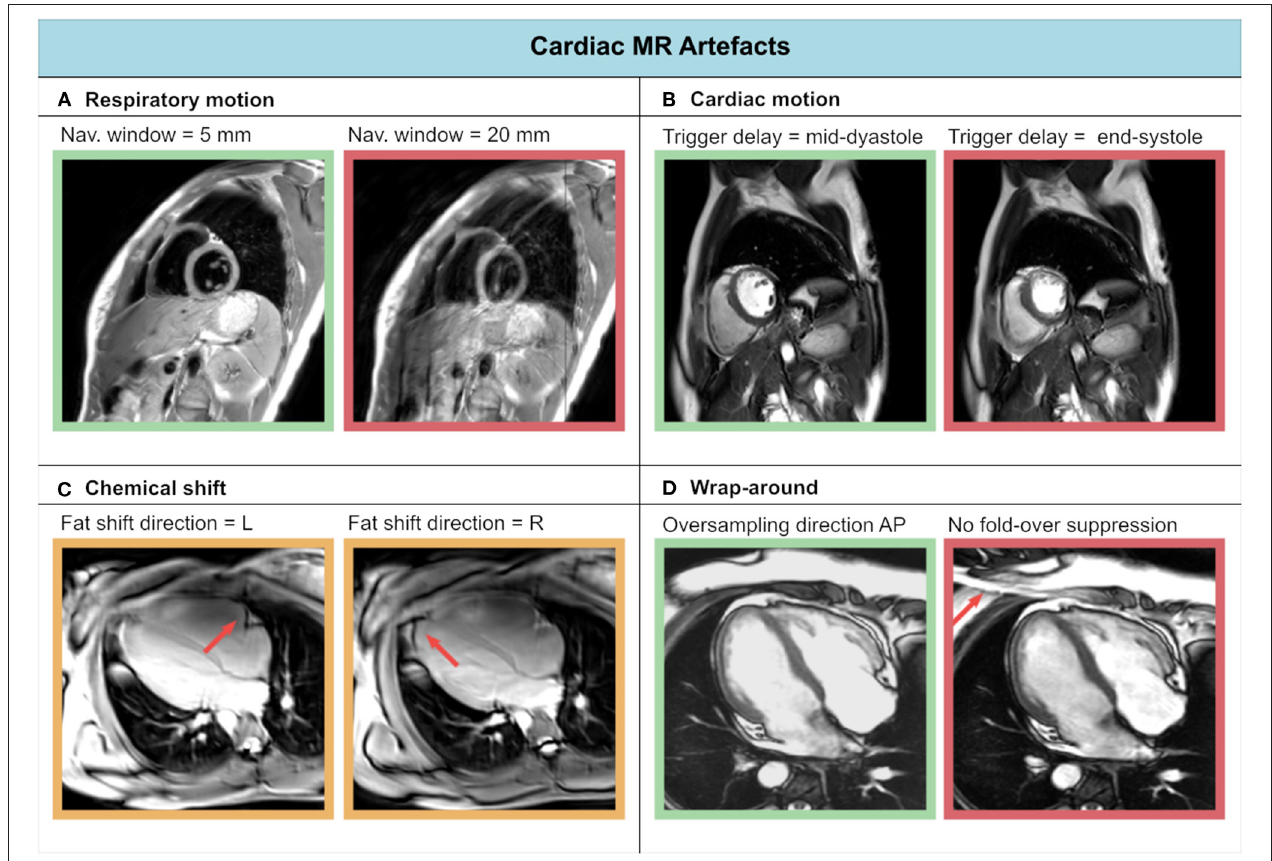
FIGURE 3 | Experienced CMR image artifacts of (A) respiratory motion, (B) cardiac motion, (C) chemical shift, and (D)